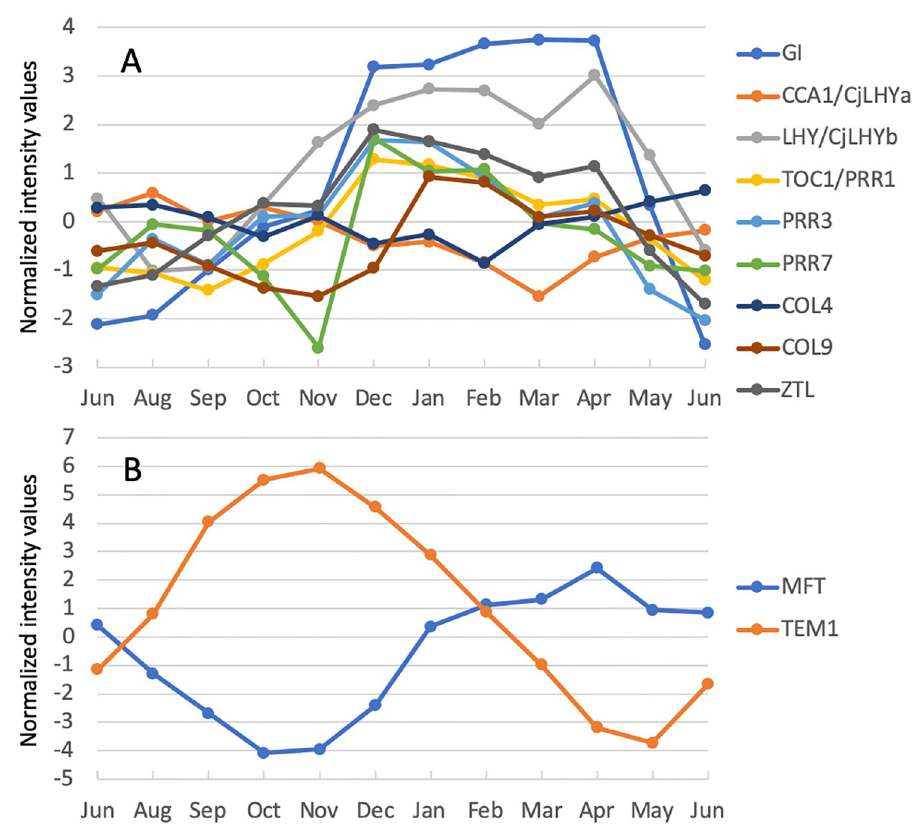
Fig 7. Annual expression pattern of clock-related genes and PEBP family-related genes under field conditions.